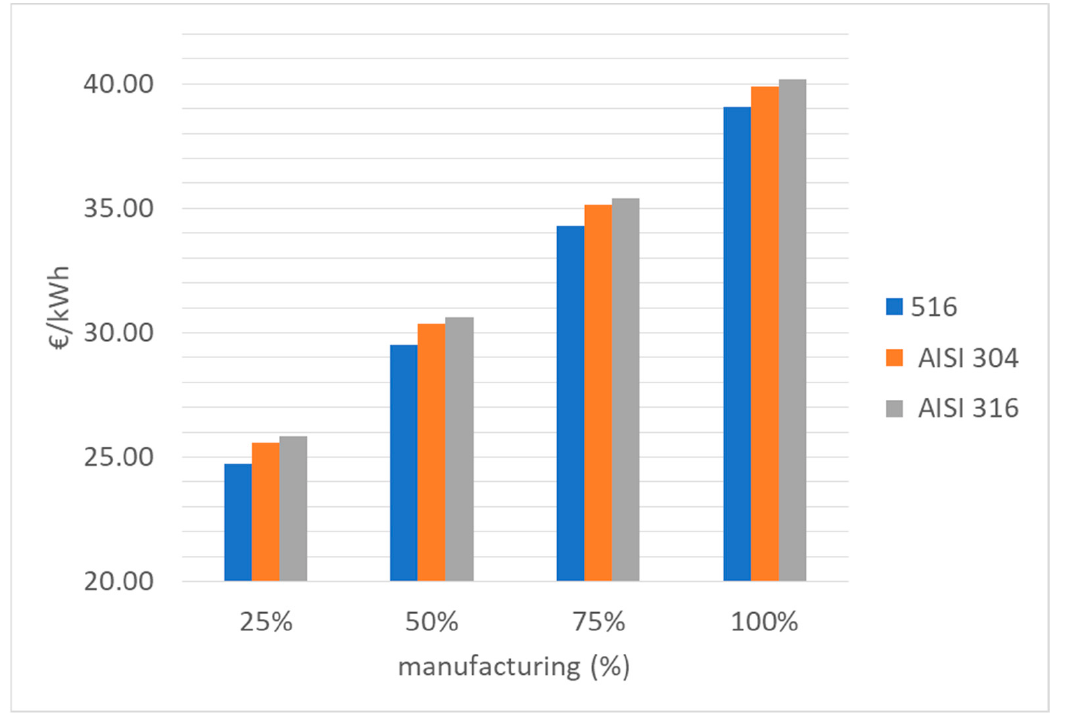
Figure 9. Investment cost analysis by varying PCM encapsulation cost percentage.